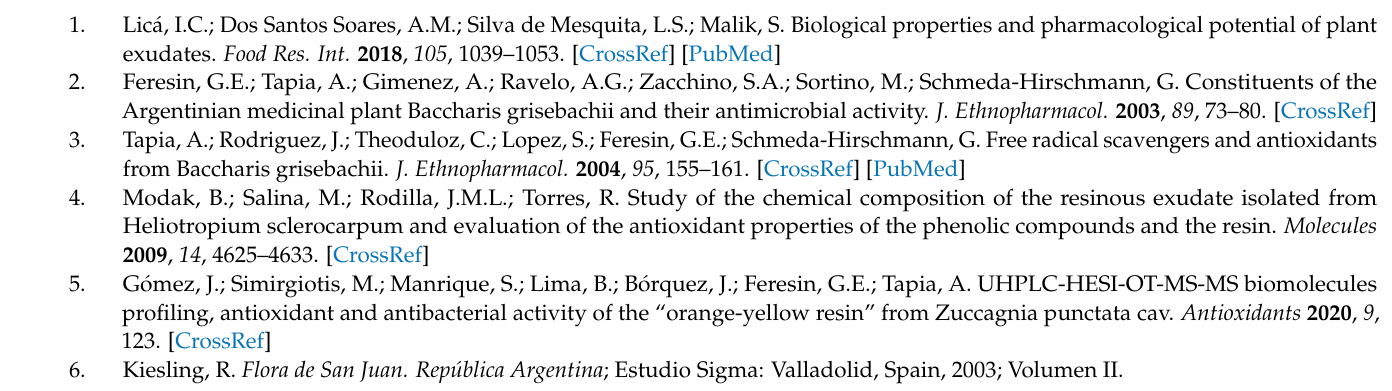
/s1; Figure S1: Representative panel of Checkerboard design combining Larrea resins (LR) with Cefotaxime (Cef). GC stands for growth control. Dark circles show bacterial growth and white circles show no bacterial growth, Figure S2: Full orbitrap MS spectra and structures of representative compounds 13, 16, 20, 26 and 28 ( a – e